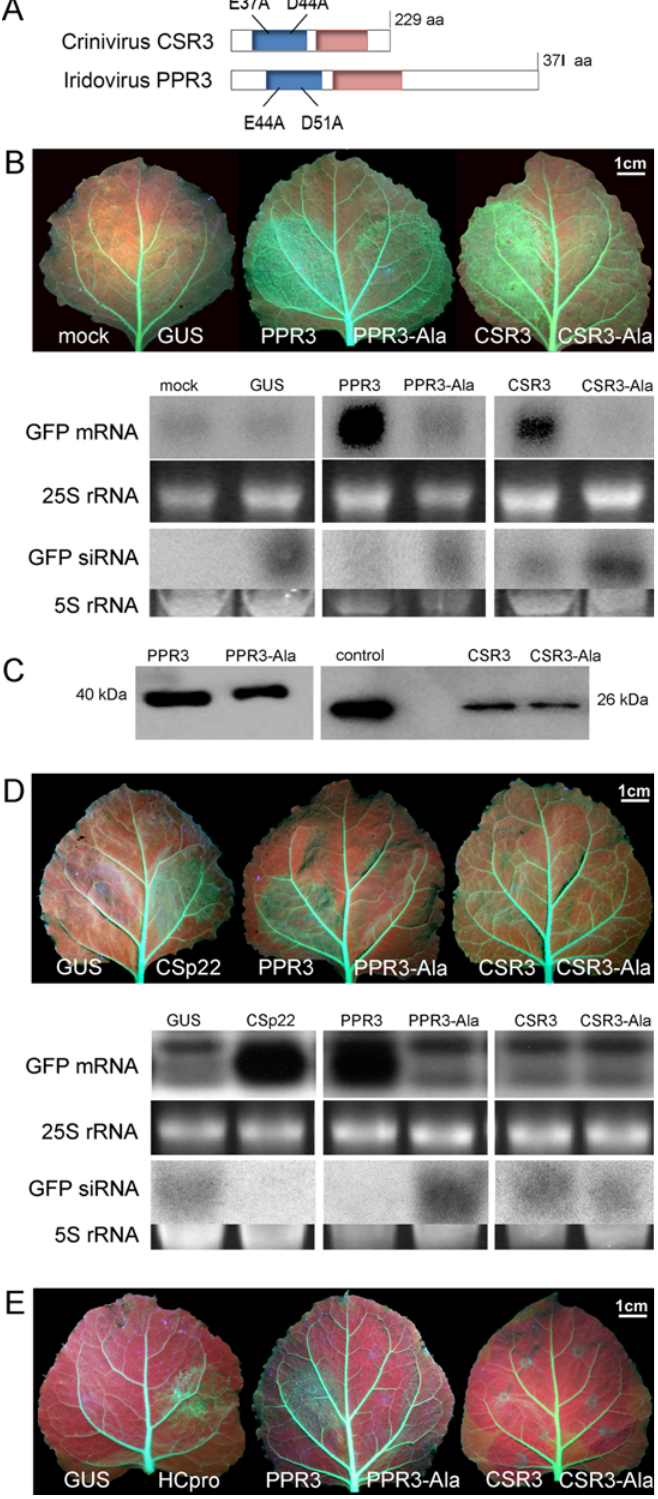
Fig 1. Class 1 RNaseIII endoribonucleases of PPIV (PPR3) and SPCSV (CSR3) suppress RNAi in leaves of Nicotiana benthamiana . ( A ) The RNaseIII signature motif (blue) and dsRNA-binding domain (red) conserved in Class 1 RNaseIII endoribonucleases, and substitution of two conserved amino acid residues of